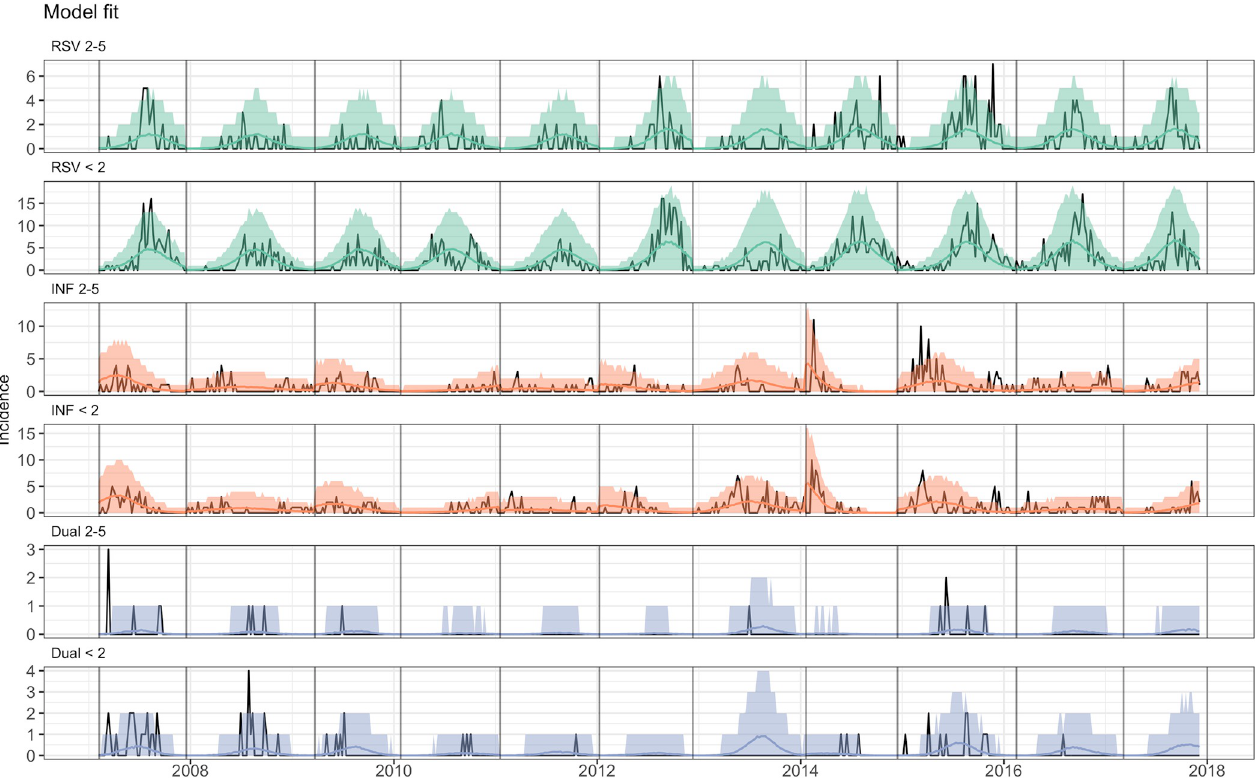
Fig 2. Model Fit: Black lines are the data, coloured lines are the 95% CrI posterior predictive interval. Panels show the fit by age group and Virus.